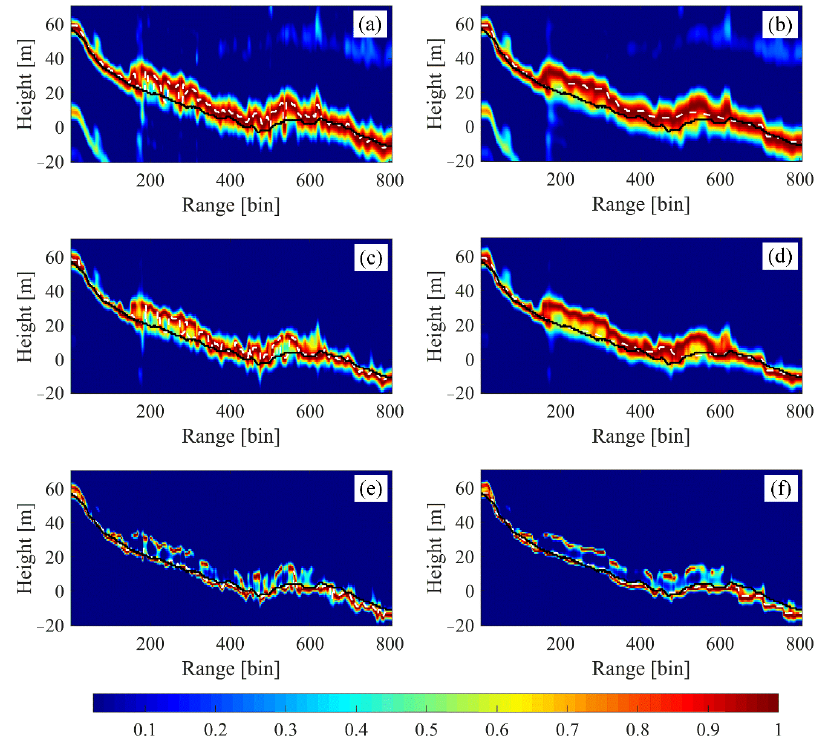
Figure 10. Tomograms of the HV polarization channel at the selected profile estimated by the different TomoSAR methods: ( a ), ( c ), and ( e ) are, respectively, the results of LM-based beamforming, Capon, and MUSIC; and ( b ), ( d ), ( f ) are, respectively, the results of NLM-based beamforming, Capon, and MUSIC. The solid black line is the LiDAR DTM, and the dashed white line is the estimated values.